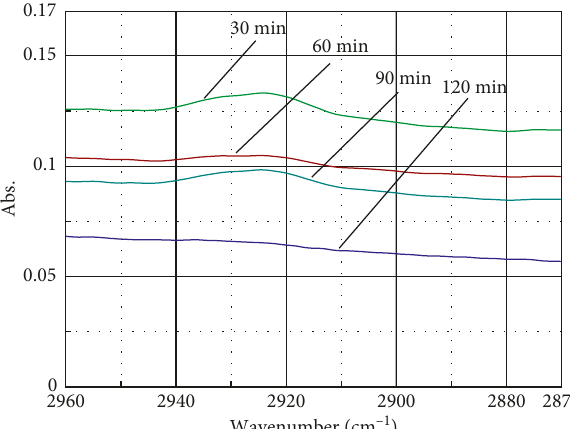
Figure 2: Spectral band characteristic of nonmineralized mixture 80% (M80) after mineralization at 500 ° C for 30, 60, 90, and 120minutes.